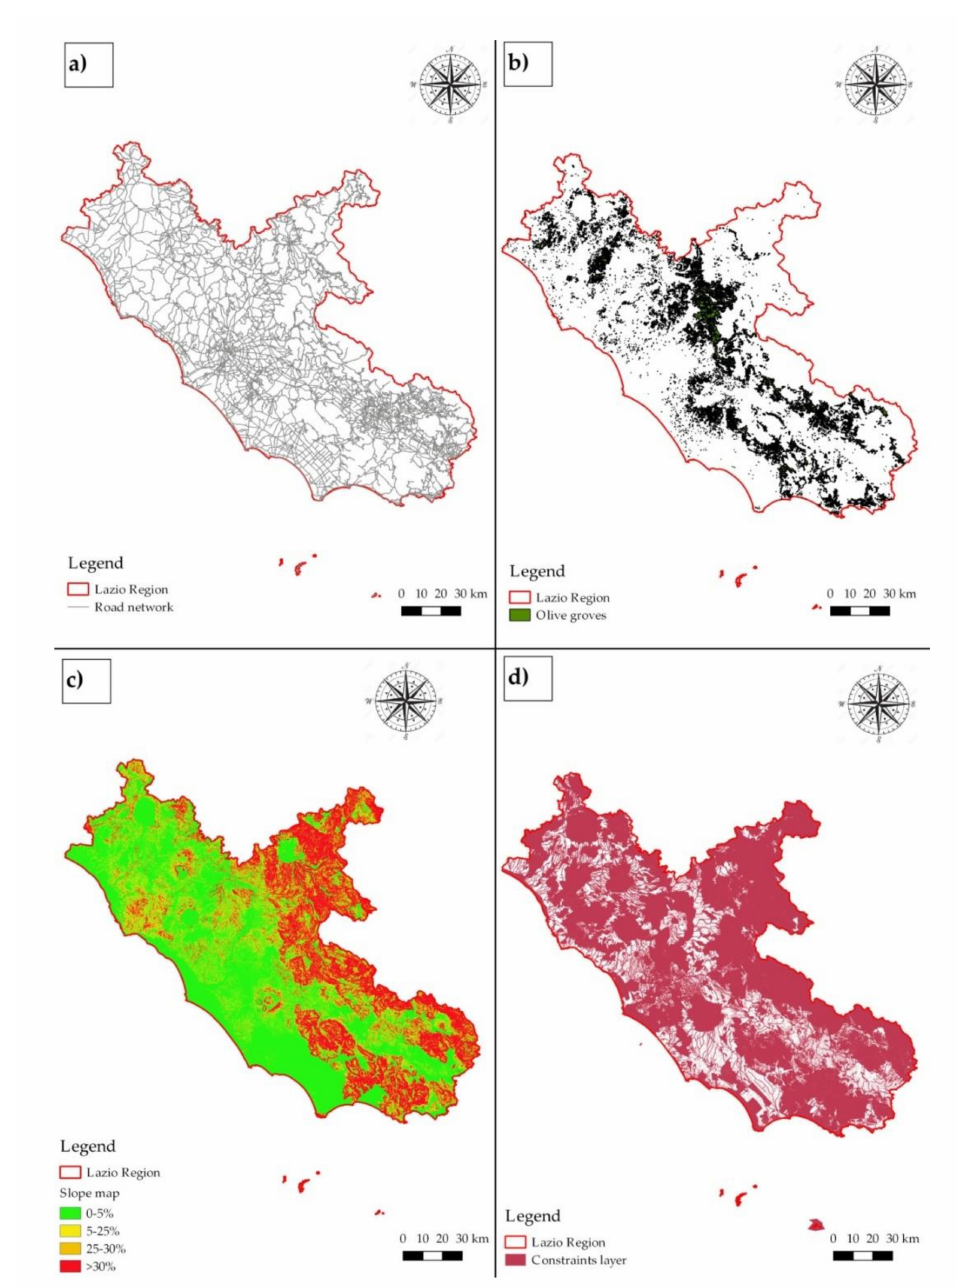
Figure 2. ( a ) regional road network; ( b ) olive groves map; ( c ) slope map; ( d ) Constraints